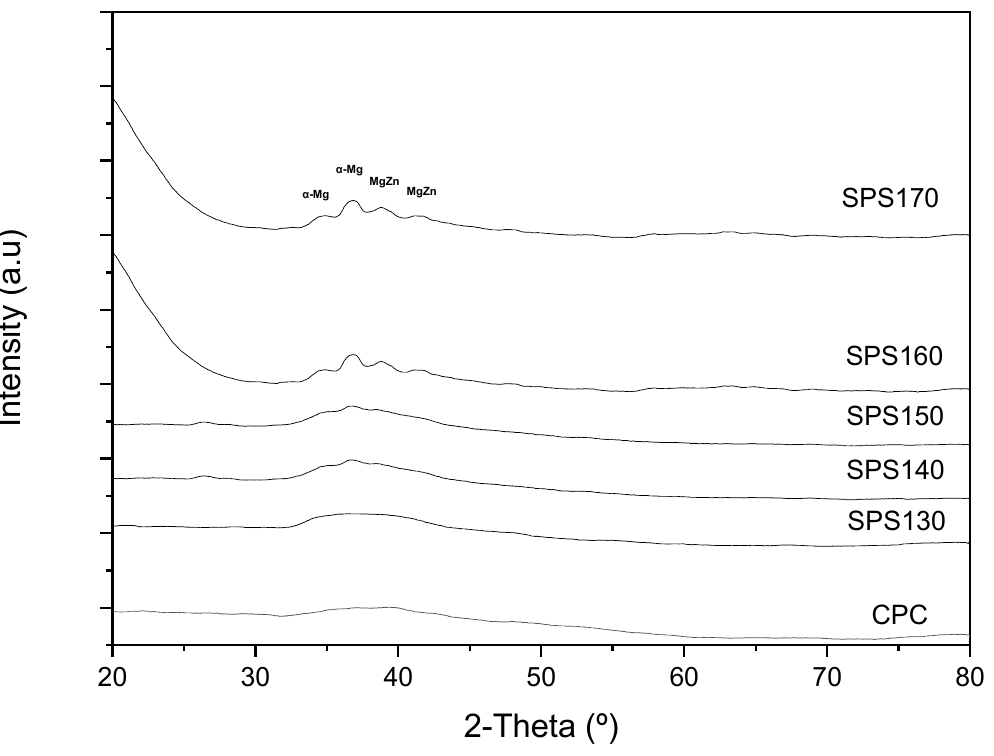
Figure 1. XRD patterns of pre-SPS–Cold compacted (CPC) and SPS-ed Mg-Zn-Ca ribbons at varying temperatures from 120 °C to 170 °C.